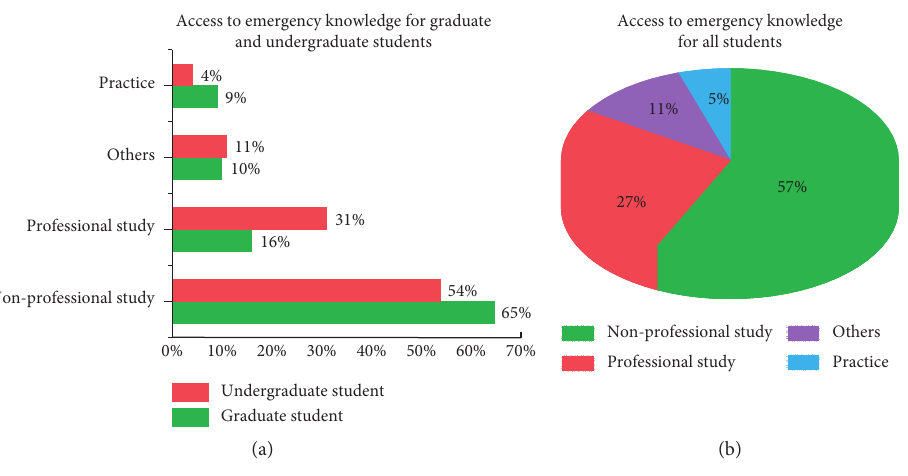
Figure 2: Access to emergency